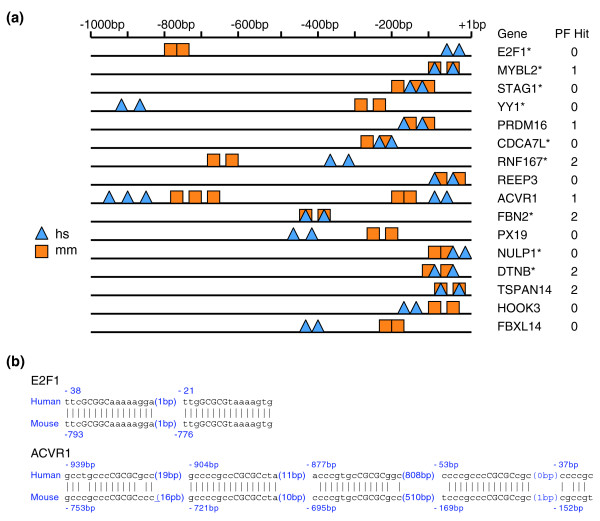
Functionally conserved E2F1 binding sites in human and mouse genes. (a) Schematic alignment of functionally conserved E2F1 binding sites between human (hs) and mouse (mm) promoter sequences from between-TFBS distance of 20 bp. Also listed are the numbers of conserved E2F1 binding site(s) detected by phylogenetic footprinting (PF). Asterisks indicate promoters of genes with experimentally proven E2F1 binding sites. (b) Sequence alignment of synergistic E2F1 binding sites from the E2F1 gene and two E2F1 binding site clusters from the ACVR1 gene. Core motifs are shown in upper case letters, and the distances between adjacent binding sites are shown in brackets. Also shown are the locations of each binding site in relation to the transcription start site.